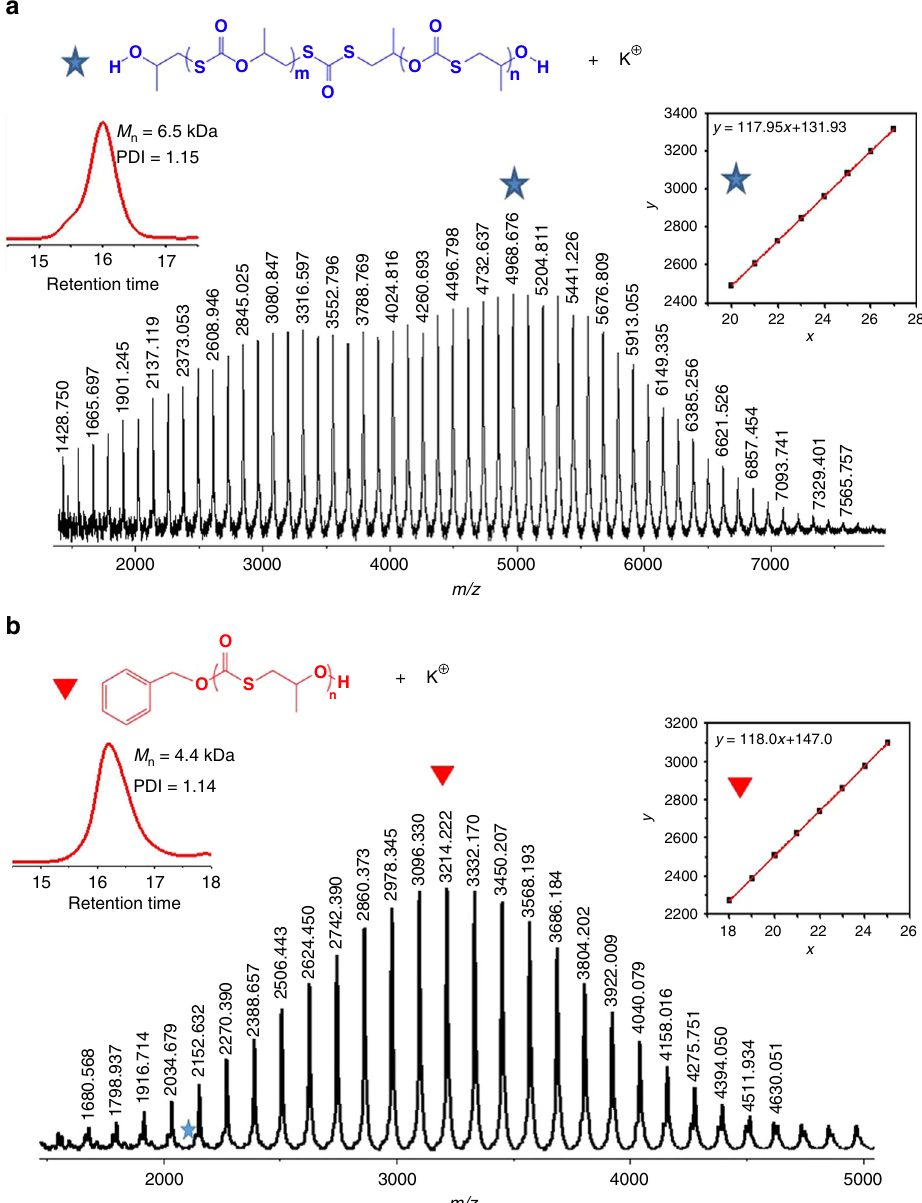
Fig. 2 Analysis of PPTMCs by MALDI-TOF MS spectra. GPC curves and M n of PPTMCs and M n vs. repeated unit number plots are inserted. a PPTMC was synthesized without BnOH, afforded α -OH, ω -OH-terminated [H + (PO + COS) m + n + (PS + COS) + PO + OH + K + ] copolymer with one dithiocarbonate unit ( M n : 6.5 kg/mol; PDI: 1.15); b PPTMC was synthesized with BnOH, afforded α -OBn, ω -OH copolymer-terminated [BnO + (PO + COS) n + H + K +